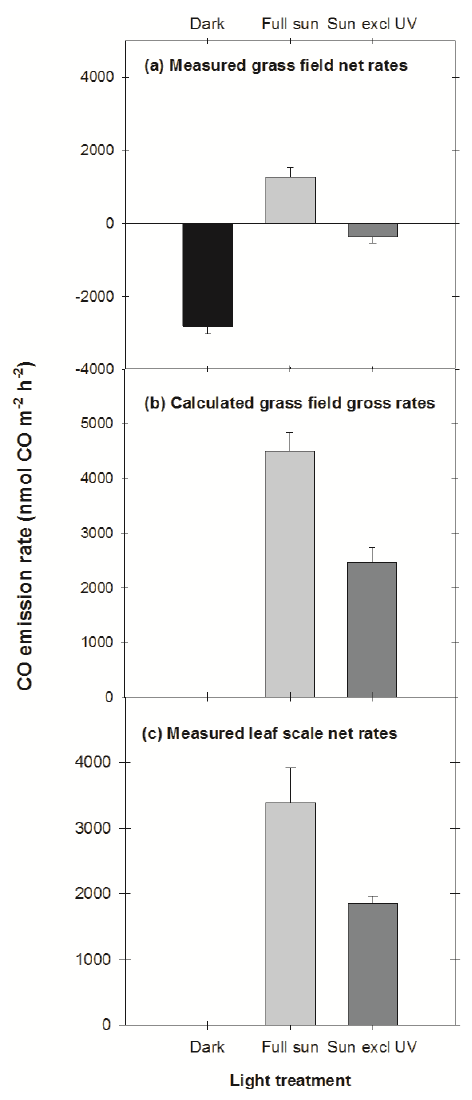
Fig. 1. (a) Measured natural grass field net CO emission rates in dark, sunlight and UV-excluded sunlight. Measurements were con- ducted with a Plexiglas chamber at ambient temperature (grass field [ T = 21 . 38 ◦ C; n = 22]). Values shown are means ± S.E. The or- der of treatments (dark, full sunlight and sun screened for UV) was alternated between replicates. For the Plexiglas grass field chamber measurements the mean ( ± S.E.) level of UV-B (280– 315nm) was 0.50 ± 0.01Wm − 2 and the mean ( ± S.E.) PAR was 711 ± s.e. 16µmol photons m − 2 s − 1 . (b) Calculated ecosystem gross rates of CO emission. (c) CO emission rates (mean ± S.E., n = 4) of leaves cut from the natural grass field. Measurements were conducted with a temperature-controlled chamber at 25 ◦ C. The order of treatments (full sun and sun screened for UV) was al- ternated between replicates. For the temperature-controlled cham- ber measurements the mean ( ± S.E.) level of UV-B (280–315nm) was 0.51 ± 0.03Wm − 2 and the mean ( ± s.e.) PAR was 789 ± S.E. 47µmolphotonsm − 2 s − 1